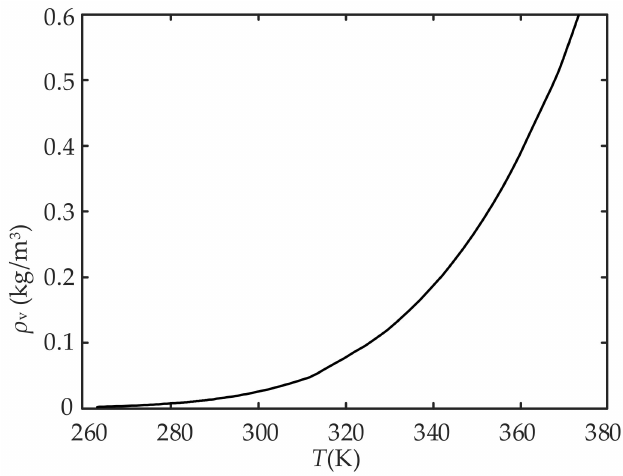
Figure 3. The relationship between ρ v ( T ) and T